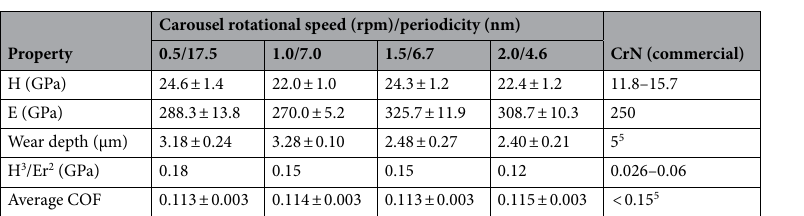
CrN (commercial)0.5/17.5 1.0/7.0